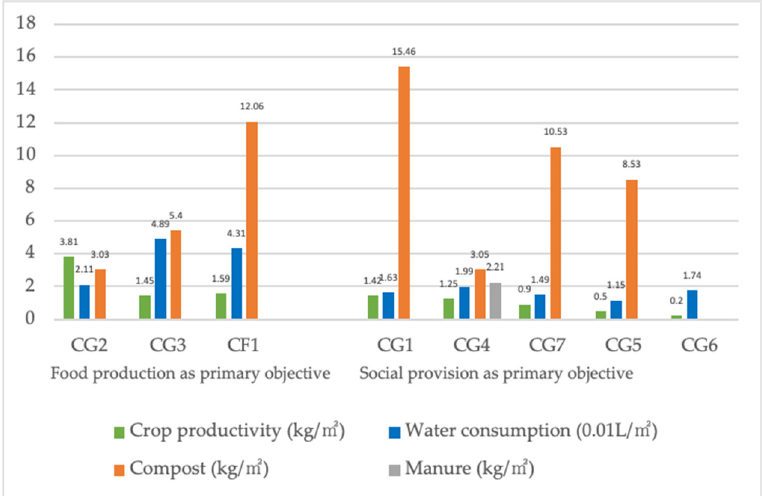
Figure 6. Summary of crop productivity, water consumption and compost/manure use. NB: Water consumption metric is divided by 100 to reduce bar lengths.